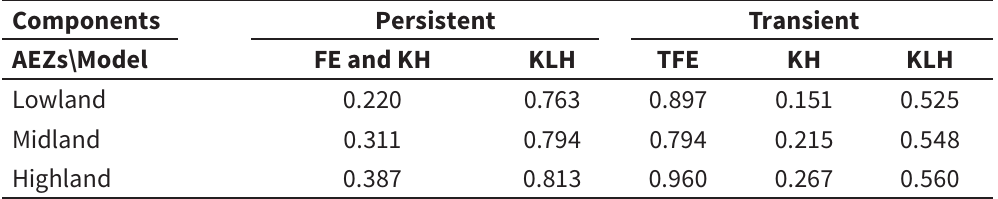
Mean efficiency measures by AEZs Components